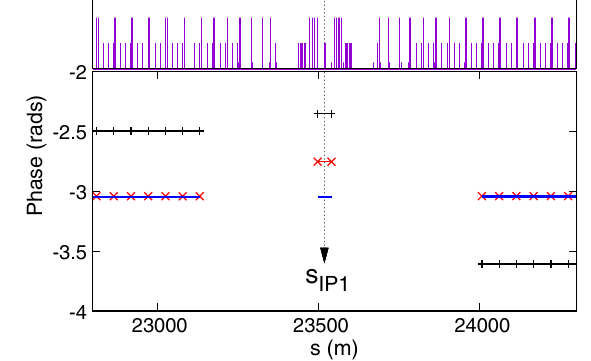
FIG. 7. Comparison between the β beating generated by magnetic errors in IR1, and the corresponding β beating after IR and triplet-by-triplet corrections are applied.